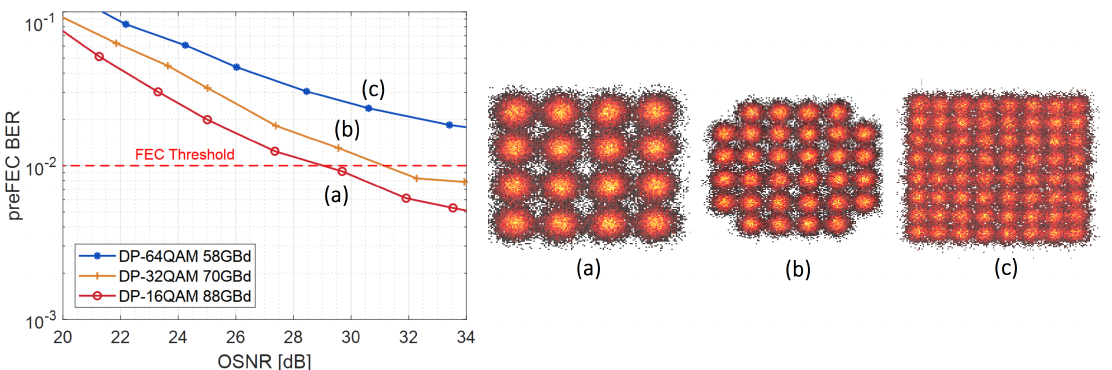
Figure 5. Back to back 600 Gb/s (+15% FEC) measurements of different modulations without nonlinear equalizers